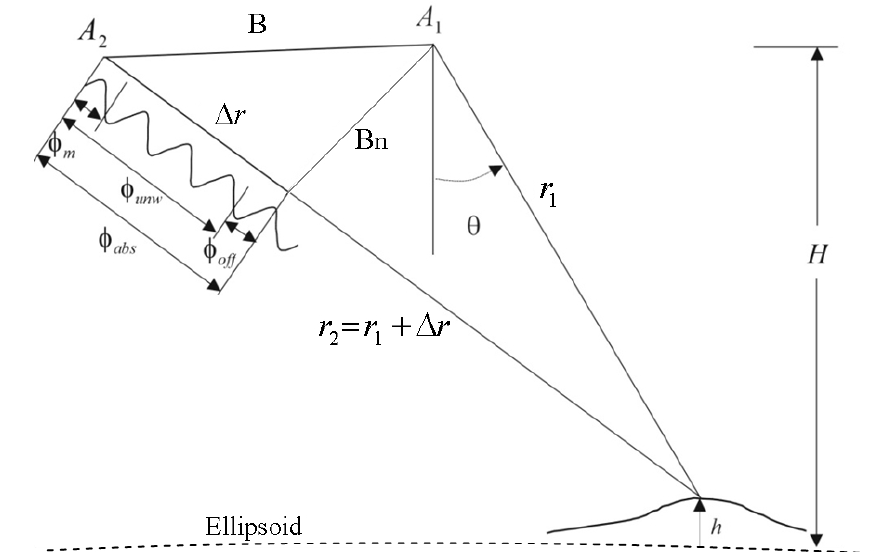
Figure 1. Representation of the interferometric phase